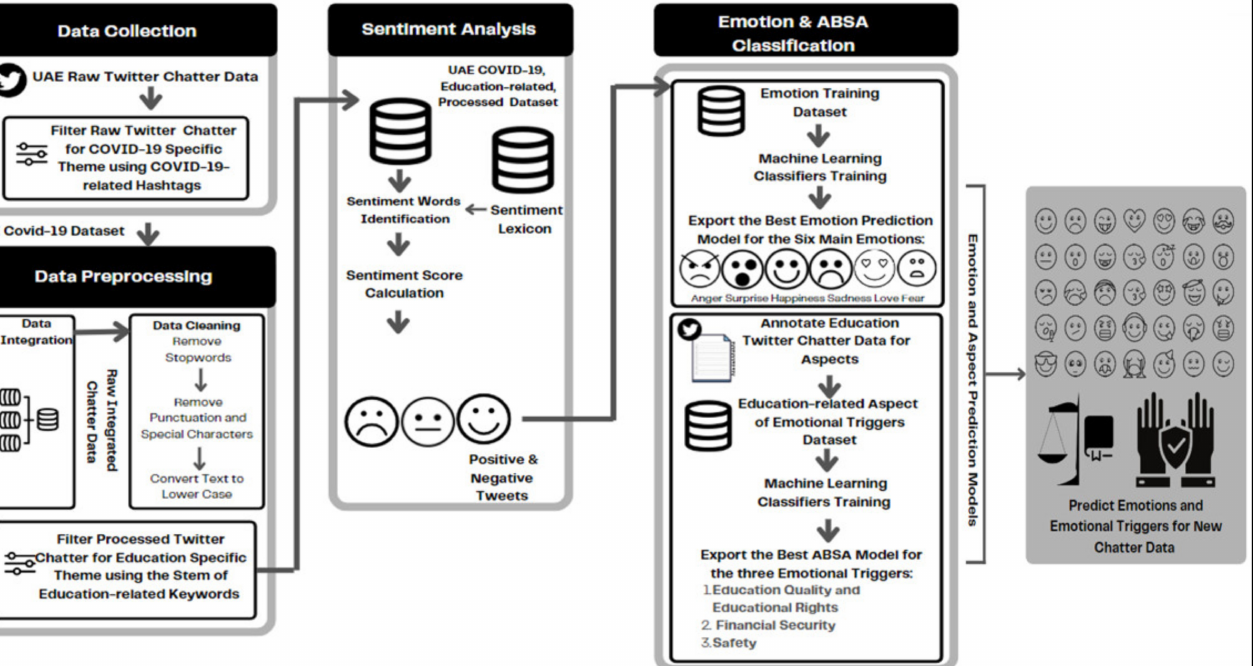
Figure 2. Analytics